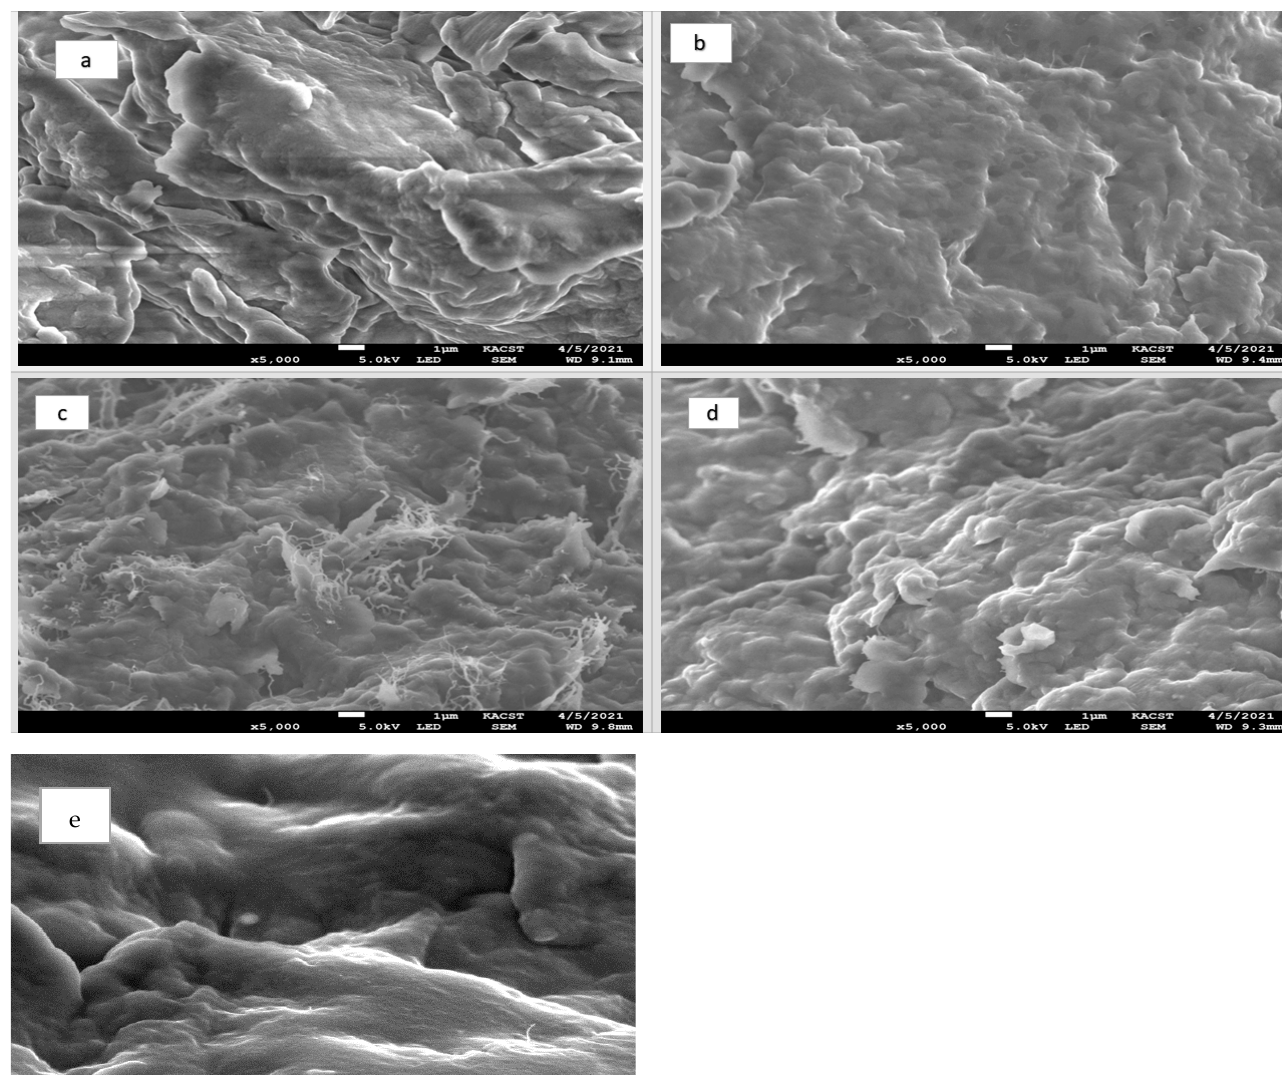
Figure 2. ( a ) SEM images of the pure PW and composites: ( b ) PW/MWCNT 2 wt.%; ( c ) PCM composite/T3 wt.%; ( d ) PCM composite/T5 wt.%; ( e ) PCM composite/T7 wt.%. Scale-bars of all photos are 1 μ m ,magnifications (up to ×5000), voltages (5.0 Kv).